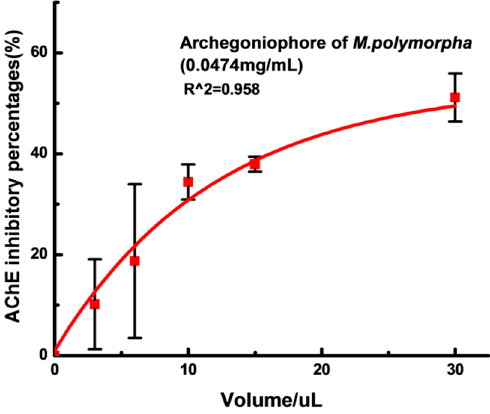
Figure 8. AChE inhibitory activity of archegoniophore of M. polymorpha L . ( n = 3).